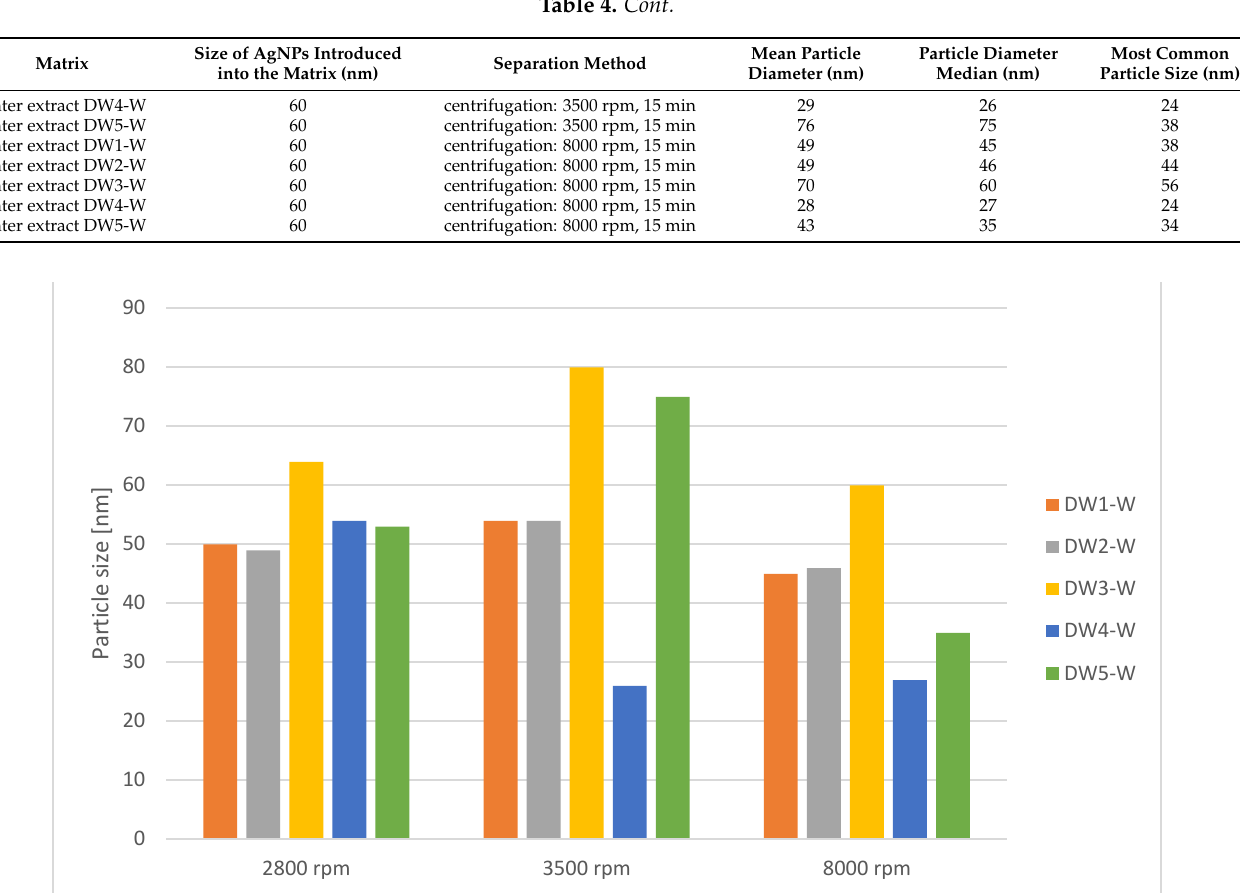
Figure 6. Results of particle size measurements in DW(1–5)-W drilling waste water extract samples with the addition of AgNPs (60 nm) for three different centrifugation speeds (2800 rpm, 3500 rpm, and 8000 rpm).